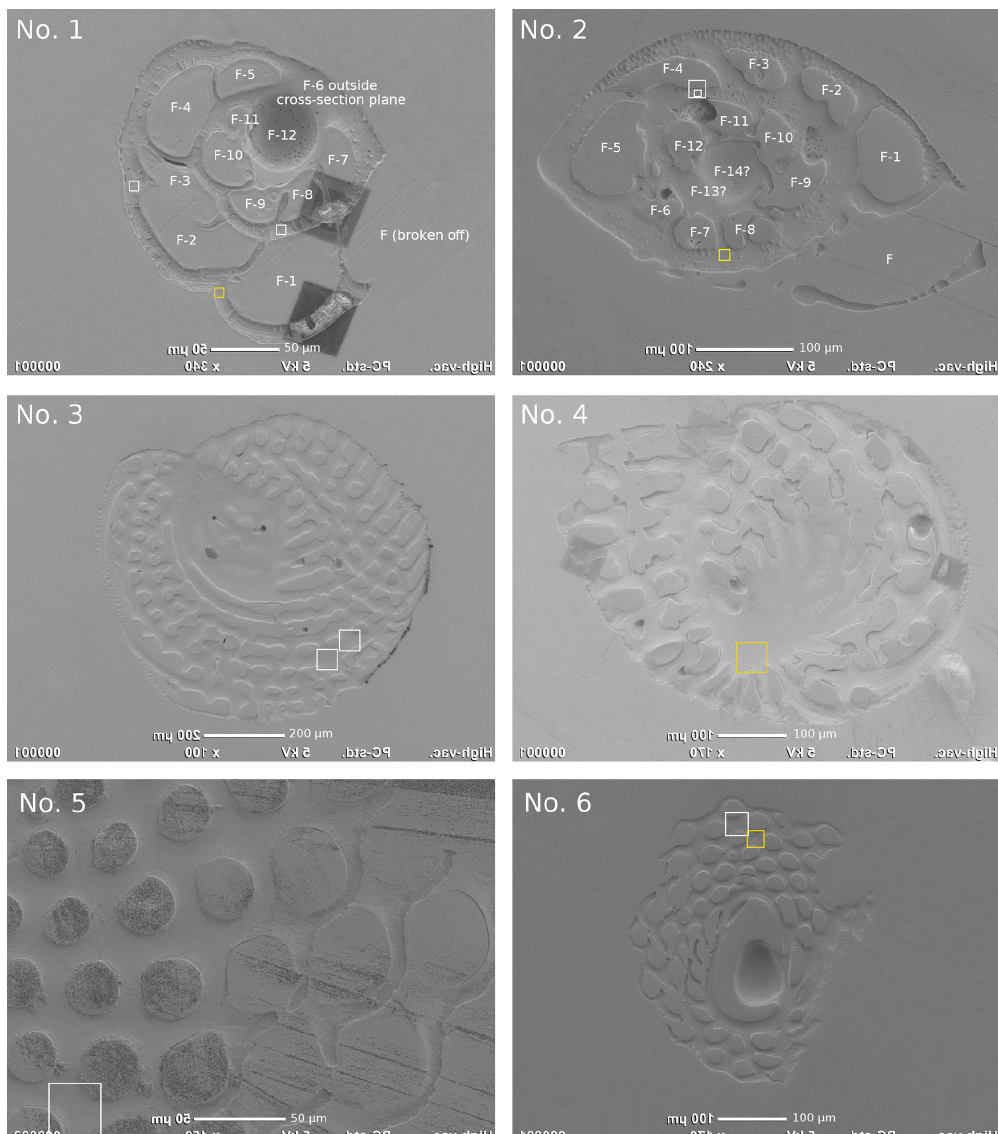
Figure A1. SEM images of the analysed specimens with the areas imaged by NanoSIMS indicated using white or yellow squares: Ammonia tepida (no. 1), Amphistegina lessonii (no. 2), Archaias angulatus (nos. 3 and 4), Sorites marginalis (nos. 5 and 6). The specimen numbers correspond to those in Tables 1 and A1. The yellow squares indicate the locations of the NanoSIMS images shown in Fig. 1. SEM images are flipped horizontally to facilitate navigation in the NanoSIMS instrument, where the secondary ion images are horizontally